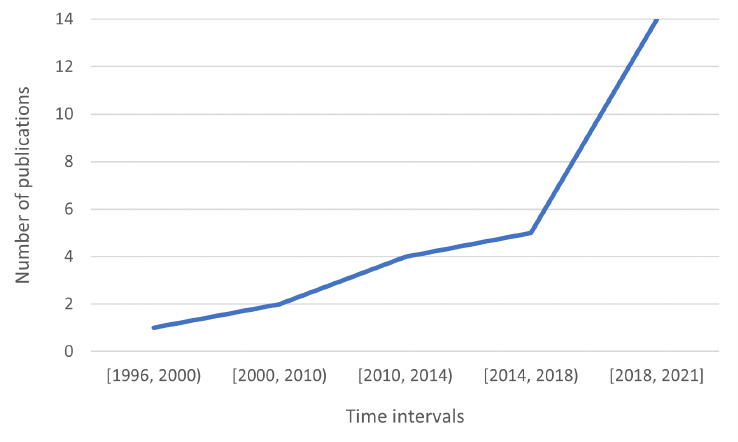
Figure 1. Number of publications in real estate RSs from 1996 to 2021.